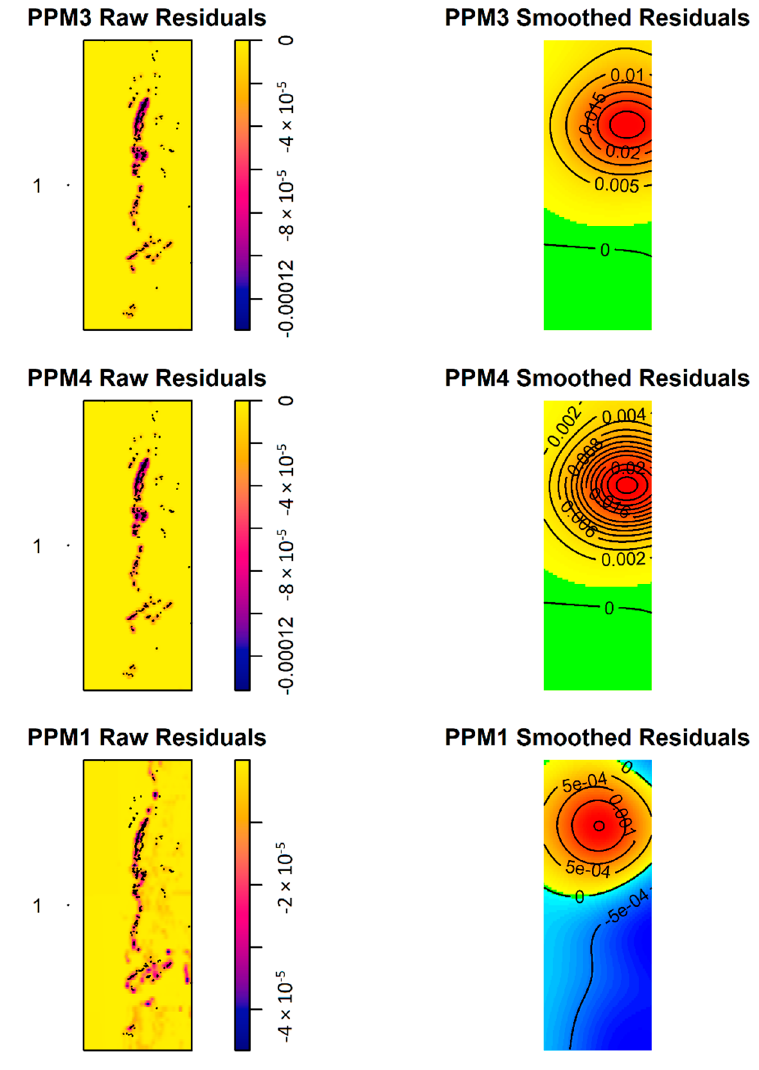
Figure 7. Map of raw and kernel-smoothed Pearson residual values of PPM3, PPM4 and PPM1. Note that the smoothed Pearson residuals for PPM3 and PPM4 contain more values of 0 (indicating a better fit), while PPM1 has more values greater than and less than 0, indicating more over- and under-fitting. Archaeological points are overlaid on top of the raw residual maps (black dots).